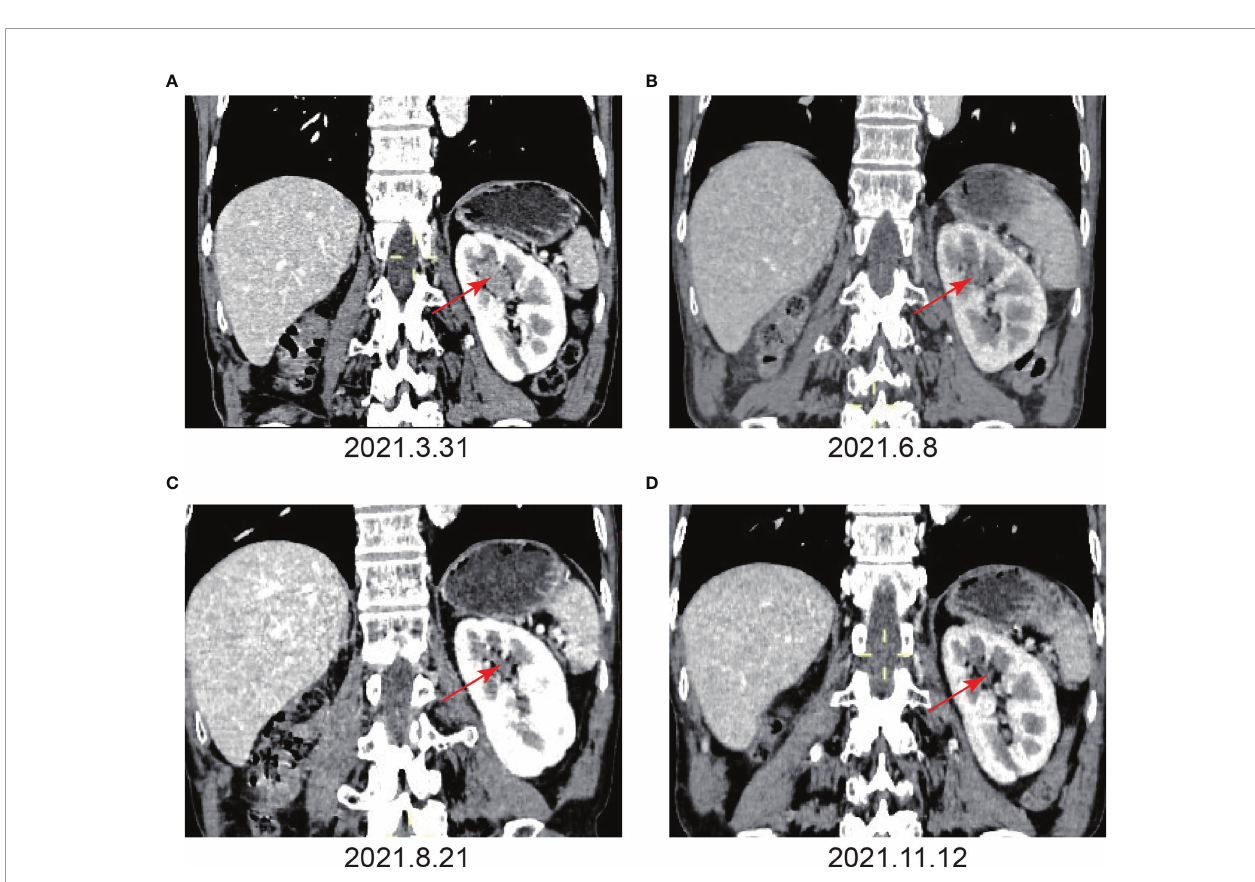
FIGURE 3 | Imaging examination before and after immunotherapy. (A) Before immunotherapy. Enhanced CT showed the absence of the right kidney, a space- occupying lesion in the upper calyx of the left kidney, approximately 27 mm×22 mm×13 mm, uniform density, partly with the renal medulla unclearly, and the enhanced scan showed obvious continuous enhancement. (B) After the fourth immunotherapy. The space-occupying lesion in the upper calyx of the left kidney was signi fi cantly smaller than before, and the size was approximately 12 mm×10 mm. (C) After the seventh immunotherapy. The space-occupying lesion in the upper calyx of the left kidney had shrunk to 4 mm×4 mm, and the enhancement degree of the lesion was signi fi cantly lower than before. (D) After the ninth immunotherapy. The space- occupying lesion in the upper calyx of the left kidney had shrunk to 3 mm×4 mm.